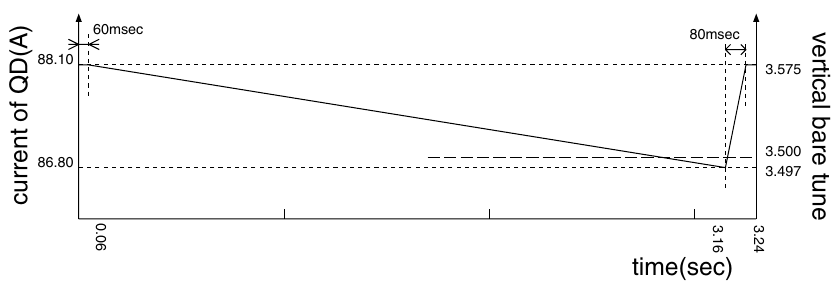
FIG. 2. Operation pattern of the vertical bare tune in resonance crossing experiments.